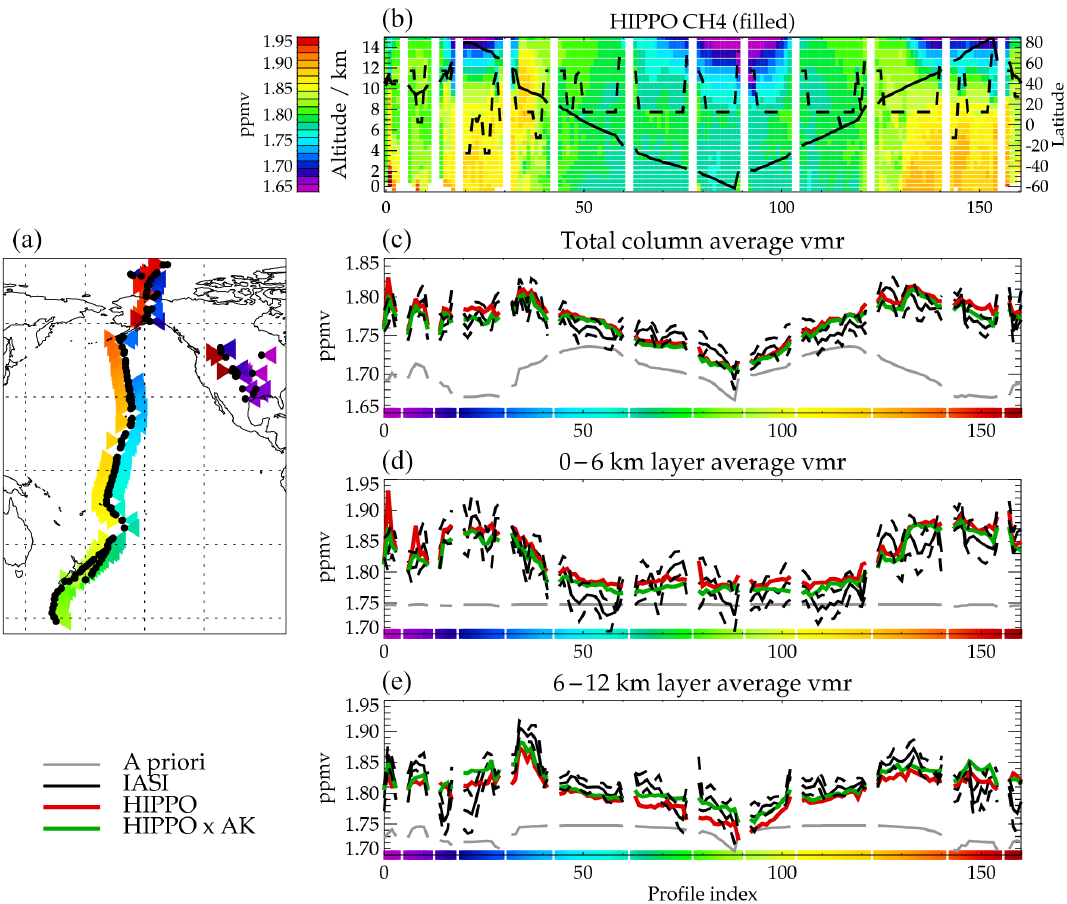
Figure 16. Comparison of IASI and HIPPO for flight campaign 5 (between 9 August and 9 September 2011). Panel ( a ) shows the flight track. Actual measurement locations are indicated with black dots; associated coloured triangles indicate the profile index, as shown on the x axis of panels on the right (b–e) (colours under the axis correspond to colours used in the map). Panel (b) shows the cross section as measured by HIPPO, after binning and filling (upwards) using the MACC GHG reanalysis. The solid black line in this plot shows the latitude of each profile (refer to y axis on the right); the dashed black line shows the maximum ( z ∗ ) altitude of the HIPPO measurement, above which profiles are filled with MACC. Gaps (filled with white) between the coloured regions divide data from different flights (on different days). Panels (c–e) compare IASI and HIPPO column- and layer-averaged mixing ratios. The mean of matched IASI retrievals is shown in black. The dashed lines show the mean ± SD of the matched retrievals. Grey shows the IASI a priori; red shows the HIPPO result; green shows HIPPO after applying the IASI averaging